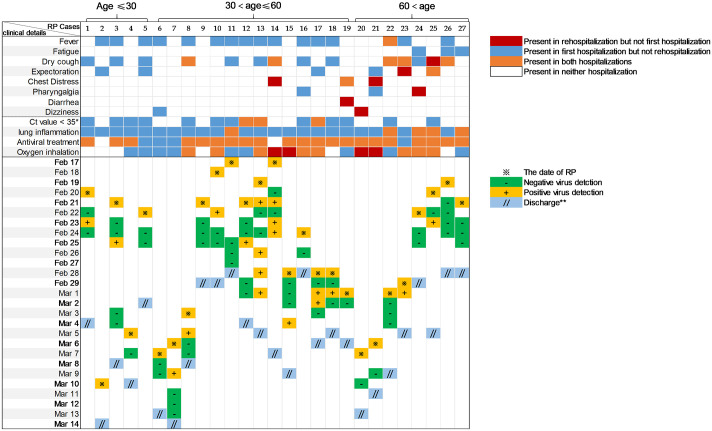
Comparison of the two hospitalization courses of 27 RP patients and result of series SARS-CoV-2 RNA test in nasopharyngeal swab specimens during the second hospitalization.Comparisons of clinical condition between first and second hospitalization are shown for each RP patient (upper panels). Timeline of series SARS-CoV-2 RNA test (lower panels) during rehospitalization are shown. *Ct value <35 refers to whether the lowest Ct value during hospitalization is lower than 35. **Discharge indicates two throat-swab samples negative for SARS-CoV-2 RNA obtained at least 24 h apart. This figure showed that elder RP patients (≥ 60 years old) were more likely to be symptomatic compared to younger RP patients (7/8, 87.5% vs. 3/19, 18.8%, p = 0.001) at readmission. RP = redetectable as positive. NRP = non-redetectable as positive.